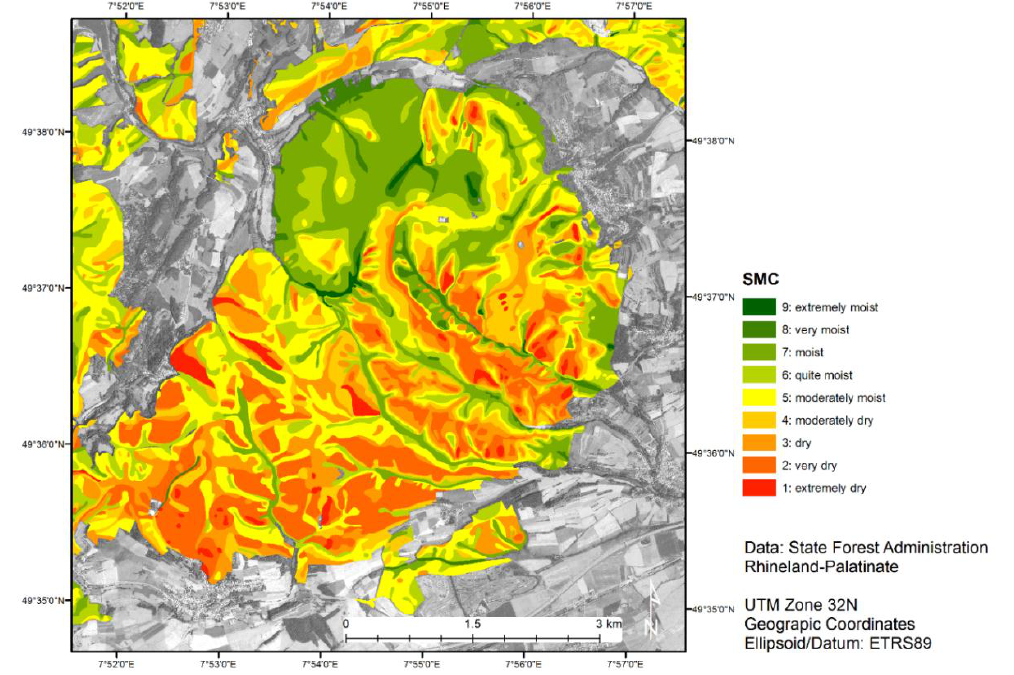
Figure 3. Soil moisture regime classes (SMC) in the Donnersberg